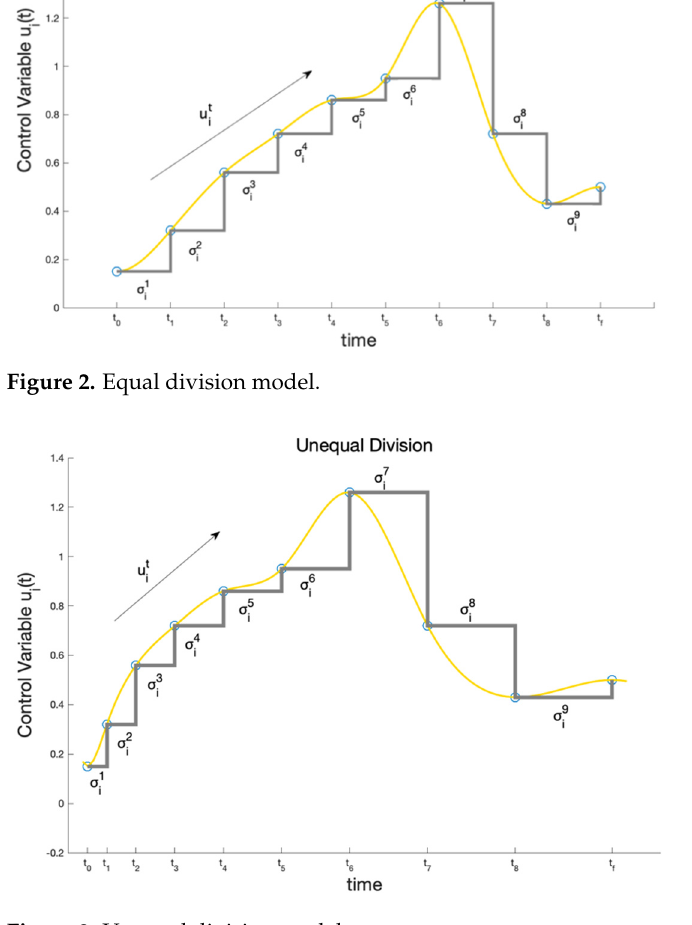
Figure 3. Unequal division model.